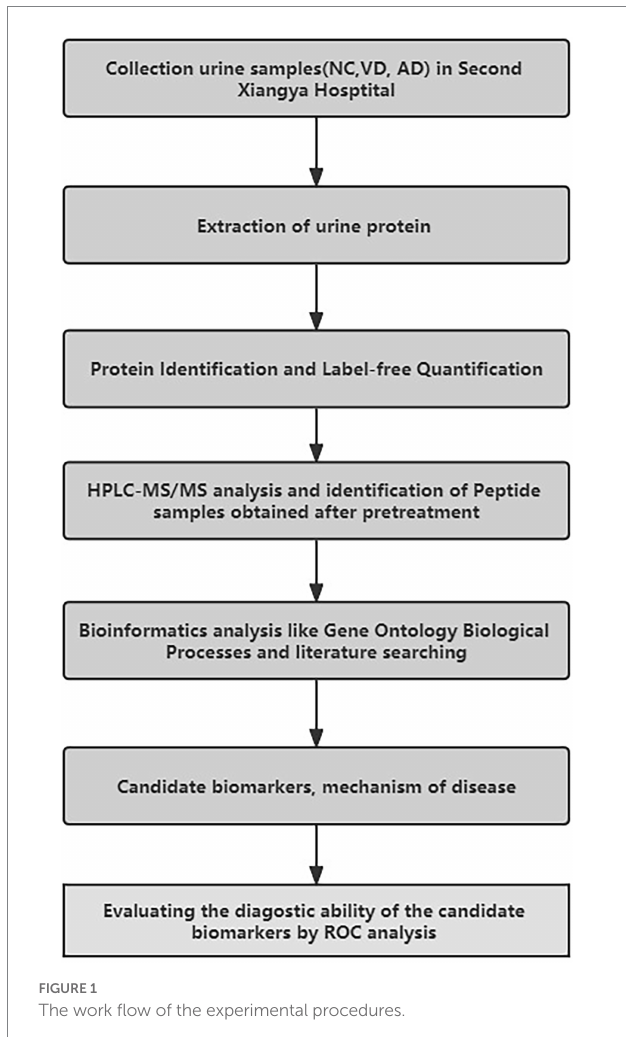
FIGURE 1 The work flow of the experimental